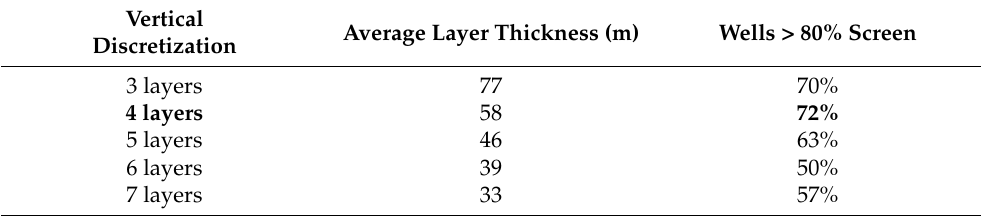
Table 3. Percentage of wells included in the model, for which 80% or more of their screen will fall within a single layer. Thicknesses are approximated from the hydrogeologic surfaces developed by Hart et al.